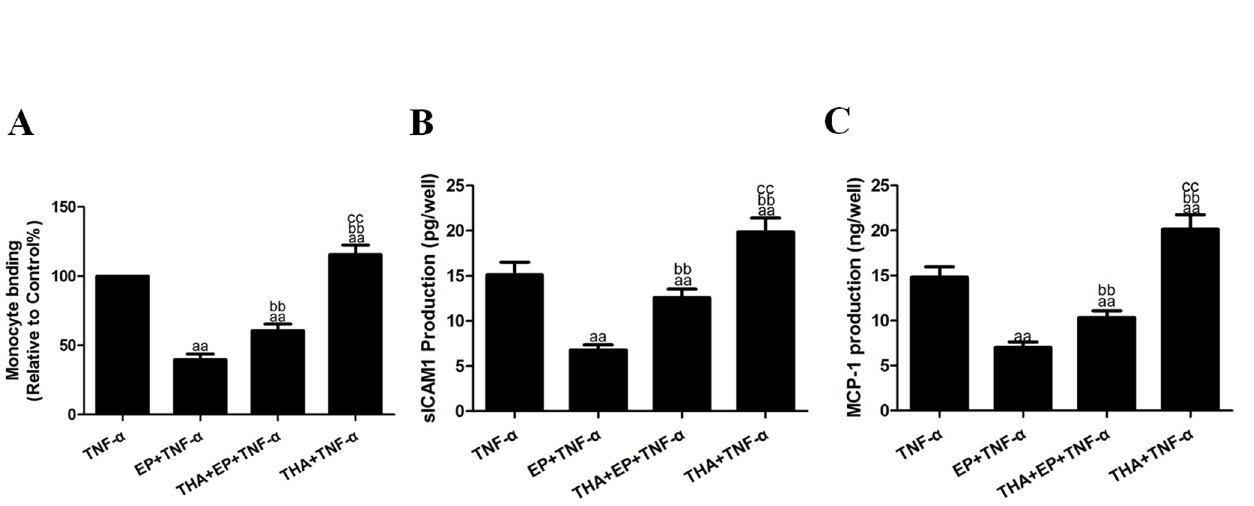
Figure 4. Effects of EP and THA co-treatment on TNF- a -induced inflammatory cytokines in cell culture supernatants. A. The adhesion of U937 monocytes to HUVECs. B. The levels of sICAM1 production in cell culture supernatants. C. The levels of MCP-1 production in cell culture supernatants. The results are expressed as the means ¡ SD, n 5 6. aa P , 0.01, compared with the TNF- a group; bb P , 0.01, compared with the EP + TNF- a group; cc P , 0.01, compared with the EP + THA + TNF- a group. EP, ethyl pyruvate; THA, thapsigargin.